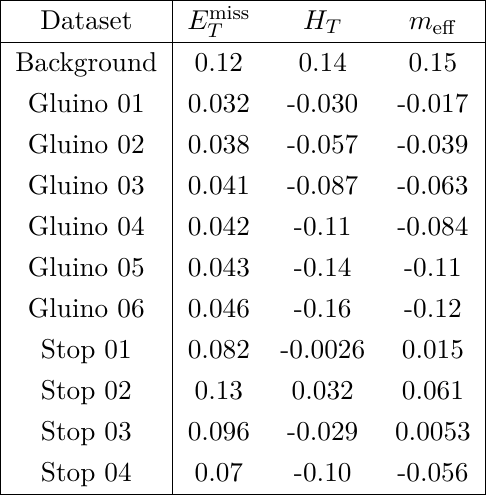
Table 5 . Pearson correlation coefficients between the AND anomaly score and various physical variables for the background and signal datasets. A value of 0 implies no correlation, and a value of ± 1 implies perfect positive/negative correlation. From these values we see minimal correlation between the AND anomaly score and these physical